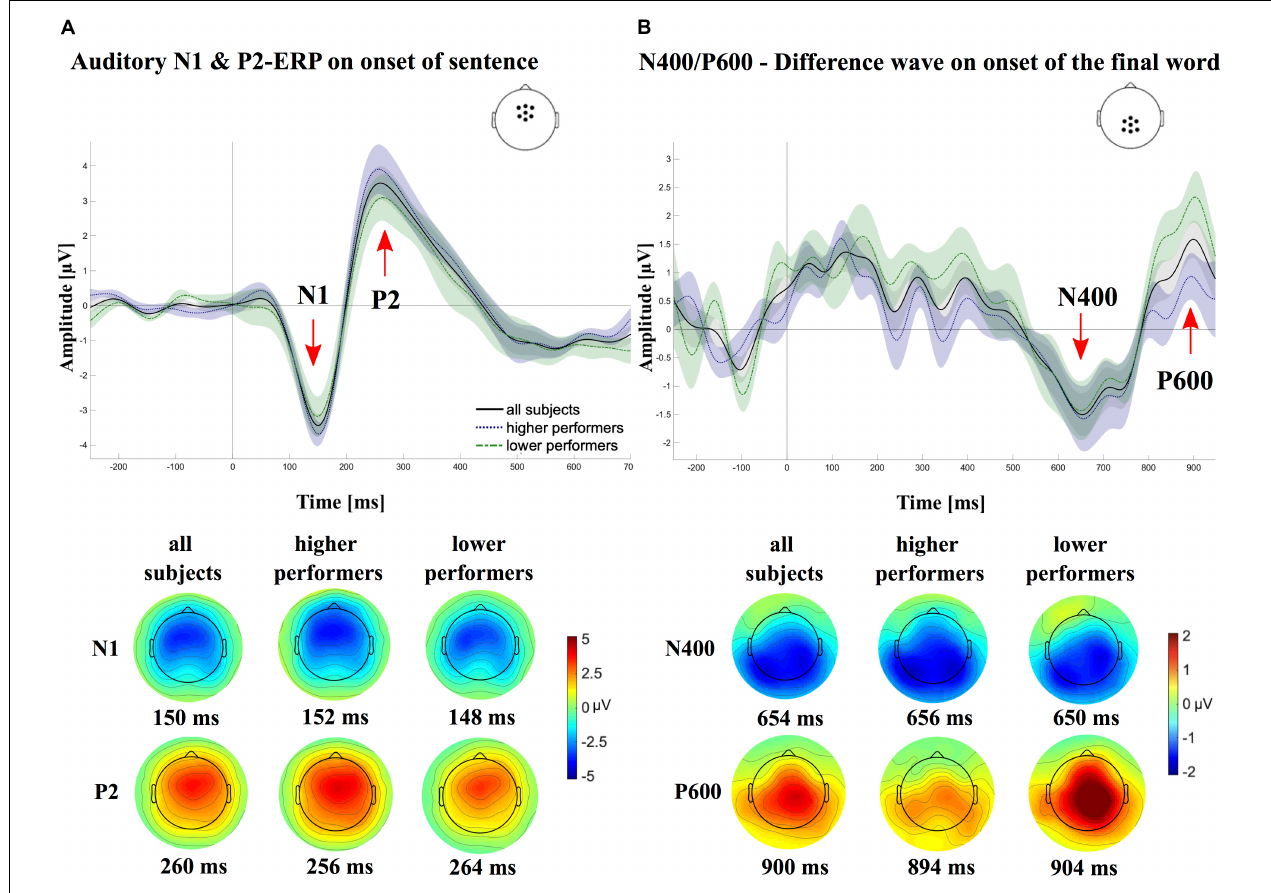
FIGURE 1 | Grand averages of the event-related potentials (ERPs), once for all subjects ( N = 21; solid lines) and once separately for the groups of higher ( N = 11; dotted lines) and lower ( N = 10; dashed lines) cochlear-implant (CI) performers. (A) Shows the grand average ERPs in response to the sentence onset for a centrofrontal electrode region of interest (ROI). A clear negative ( ∼ 150 ms) and a clear positive ( ∼ 240 ms) deflection, referred to as the N1 and P2, respectively, can be observed for all three ERPs. (B) Shows the average difference waves (ERPcritViol - ERPcritCorr), time locked to the onset of the critical words, using a centroparietal electrode ROI. A negative (N400) and positive deflection (P600) can be observed for all three ERP waves around 650 ms. At the bottom of each panel, the topographical voltage maps are displayed for the time of the respective peak latencies of the different components [N1, P2 (A) , N400 and P600 (B) , separately for the different average ERPs (all, higher performers, lower